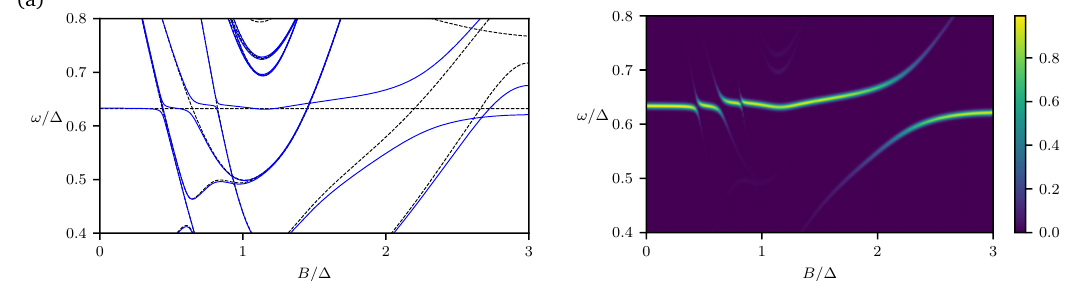
Figure 7: (a) Excitation spectrum and (b) spectral function obtained using the har- monic expansion for a finite-length junction with the same parameters as in Fig. 6. The black dashed lines in (a) correspond to the excitation energies of the unperturbed Hamiltonian, while the blue solid lines are obtained including the perturbation to lowest order in φ . The truncated basis used here consists of two lowest energy har- monic oscillator states and two-quasiparticle fermionic states constructed from four lowest energy single-particle states. For presentation purposes we plot the spectral function in (b) convolved with a Gaussian with σ = 5 × 10 − 3